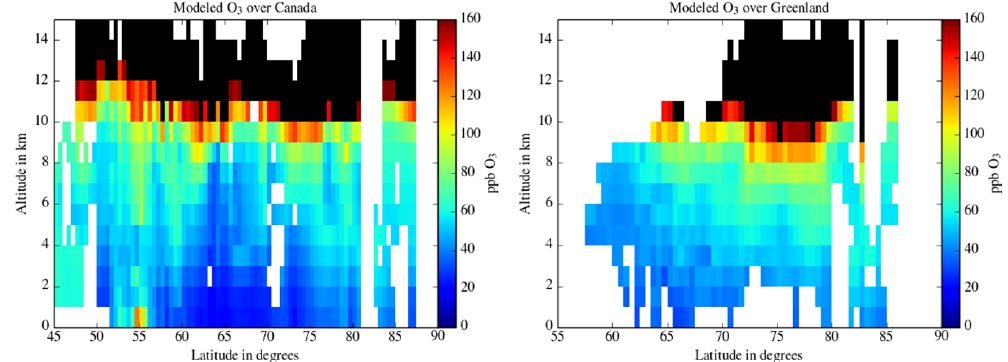
Figure 4. Same as Fig. 3 but for the WRF-Chem model ozone mixing ratio corresponding to the measurement characteristics summarized in Tables 1 and 2.